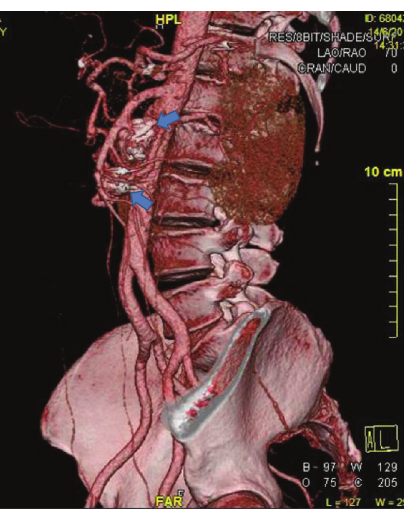
Figure 3: Follow-up imaging with volume-rendering lateral CTA views showing patent SMA and branches with thrombosis of both IPDA aneurysms and no sac